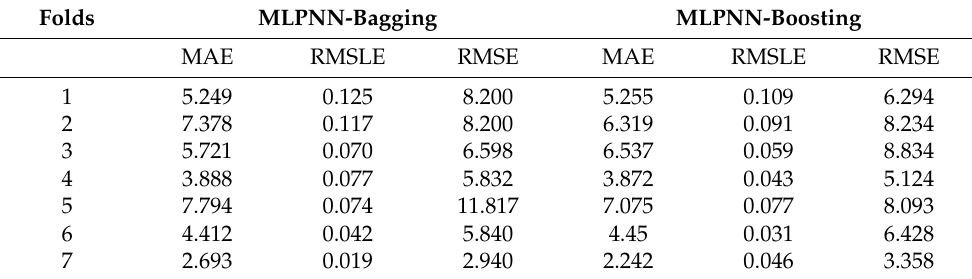
Table 11. K-Fold cross-validation result of ensemble models.